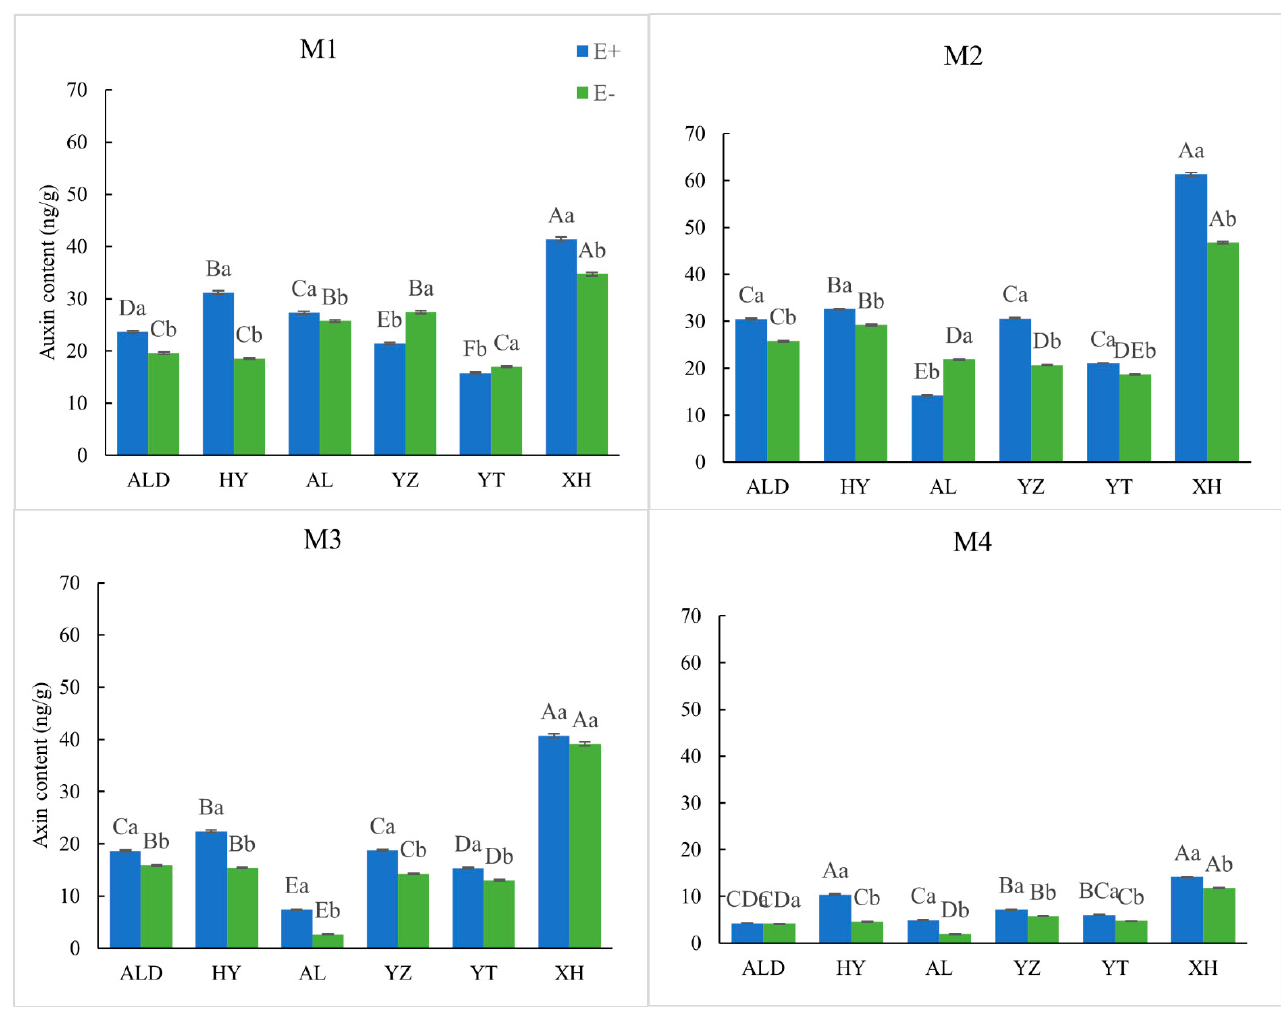
Figure 2. Relative auxin content of infected (E+) and non-infected (E − ) Achnatherum inebrians from different methods on an altitude (origin) gradient. The different capital letters indicate the mean significant difference ( p < 0.05) in endophyte status (E+ or E − ) in seed germination under different origin. Different lowercase letters indicate the mean significant difference ( p < 0.05) in the pair-wise comparisons of endophyte status (E+ and E − ) in seed germination in the same origin. Except for E − seeds from AL, which under M1 treatment, all E+ seeds showed a higher relative GA content than E − seeds (Figure 3). Both seed types under M2 treatment showed a significantly greater relative GA content than under other treatments, and all treatment results were positive compared to the CK condition.